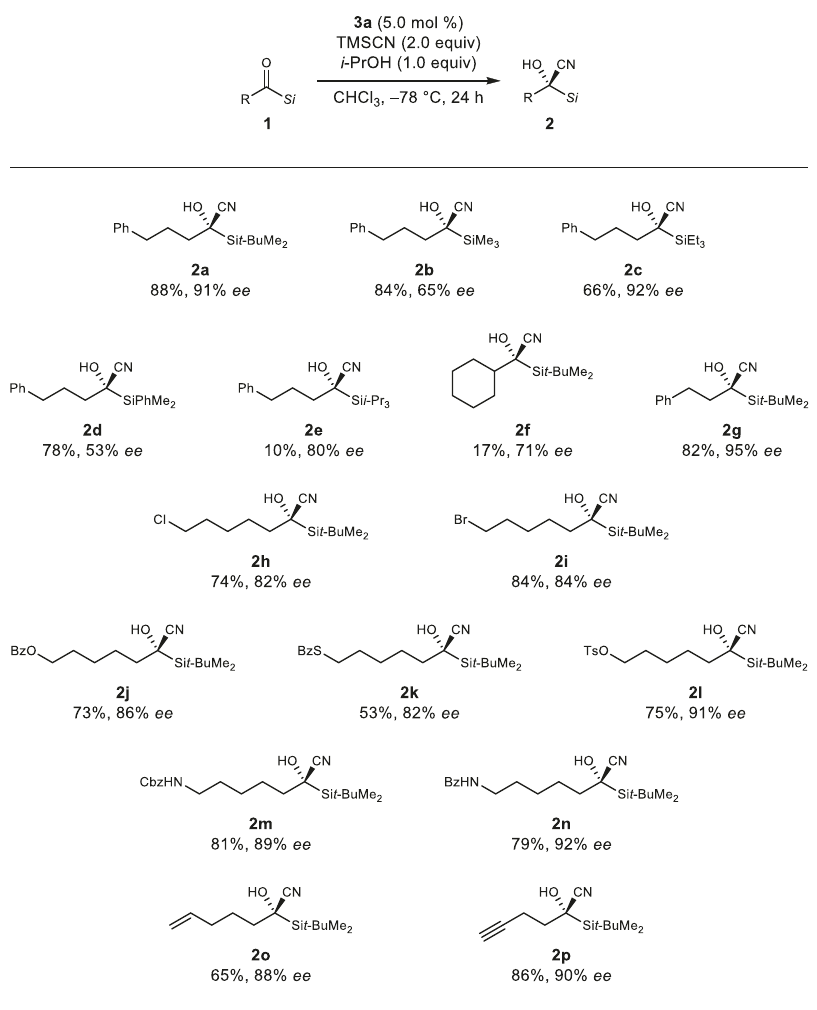
Fig. 6 Substrate scope. Reactions were run using 1 (0.20 mmol), TMSCN (0.40 mmol), i -PrOH (0.20 mmol), and 3a (0.010 mmol) in CHCl 3 (0.20 mL). Yields represent material isolated after silica gel column